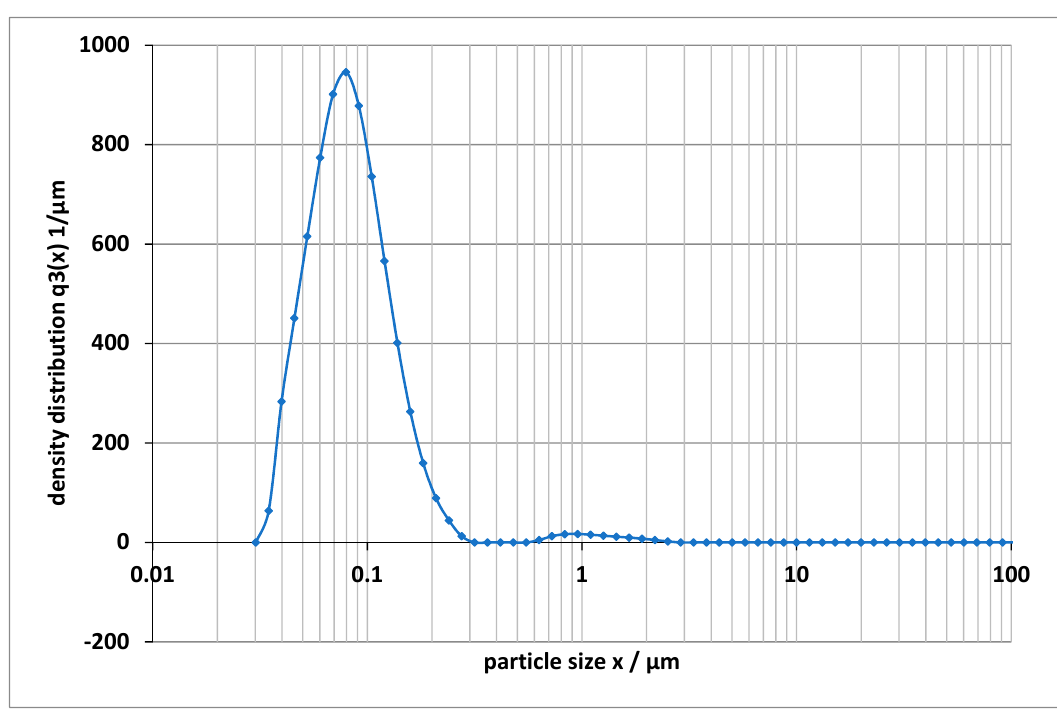
Figure 1. Particle size distribution of carbon black added to the polypropylene sample. The finished mixture was then added to an injection molding machine for producing the polypropylene samples. The test samples have a thickness of 4 mm and are character- ized by the shape of half a dog bone, see Figure 2a. The fabricated polypropylene samples with different additives are bonded using hot plate welding. For hot plate welding, a heating element temperature of 220 ◦ C was selected for the experimental investigations. The initial melt layer thickness Lo was measured for all materials according to [19] and the measured Lo revealed a value of 1.2 mm for all modifications. The dimensionless joining path is defined as the ratio of joining path sf (c.f. Figure 2b) to initial melt layer thickness Lo. Different dimensionless joining paths resulted from a change of the weld seam dimensions. Generally, a higher dimensionless joining path was induced by a higher melt fraction. All relevant process parameters are shown in Table 2. In addition, previous investigations have shown that the welding process has no influence on the crystallinity of the material [19,20].